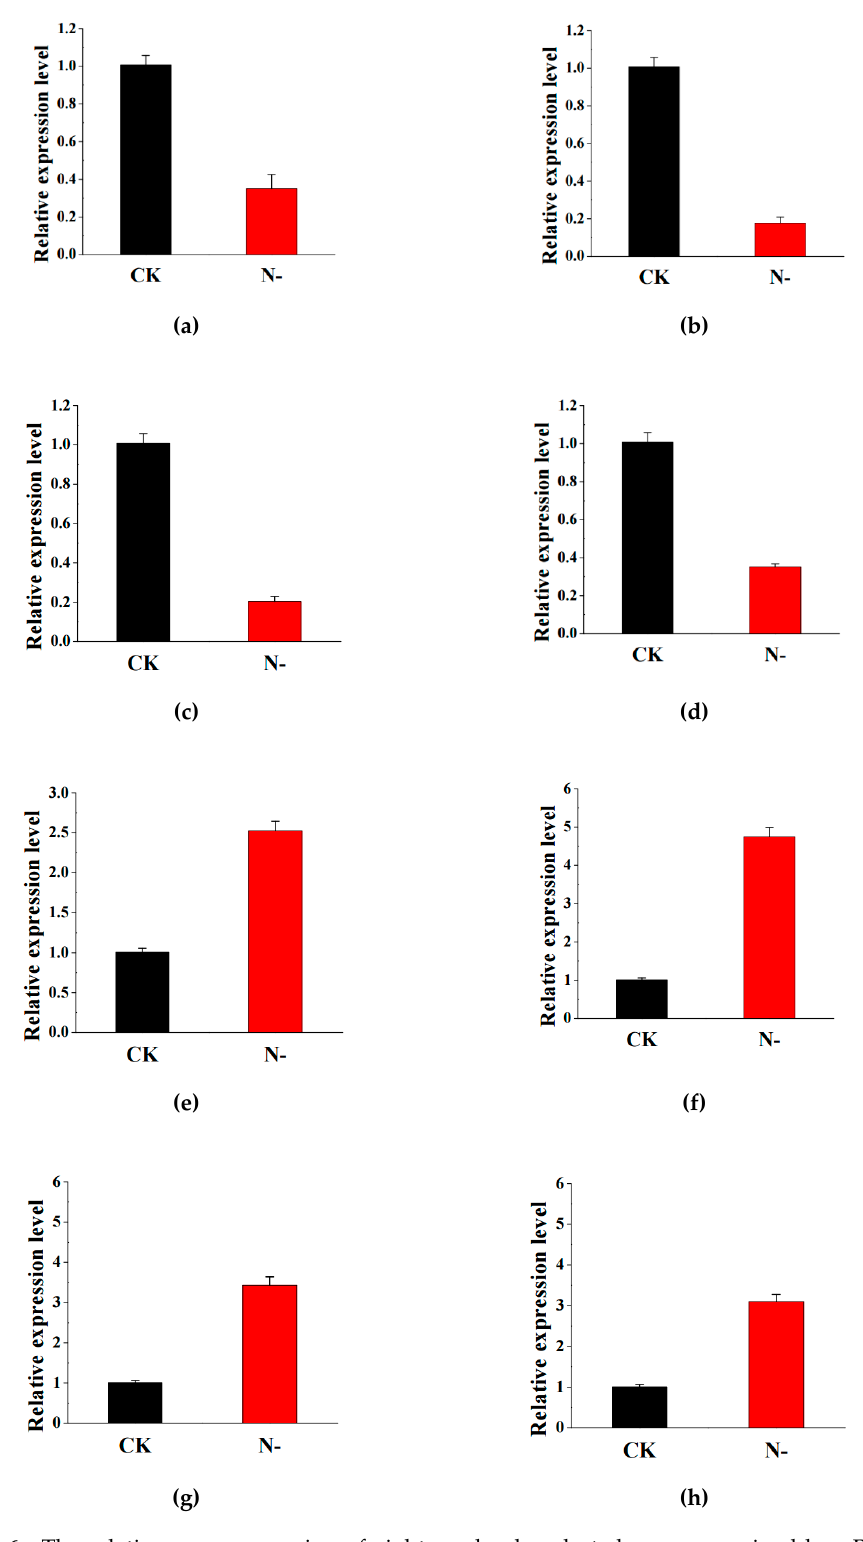
Figure 6. The relative gene expression of eight randomly selected genes examined by qRT-PCR analysis. Different treatments represent: The control (CK), low nitrogen stress (N-). Genes are ( a ) PsbP domain-containing protein 3; ( b ) MYB transcription factor 78; ( c ) Glycine cleavage system p protein; ( d ) Catalase; ( e ) WRKY transcription factor; ( f ) Asparagine synthetase; ( g ) Peroxidase; ( h ) MYB 33. Data represent the mean ± SE ( n =